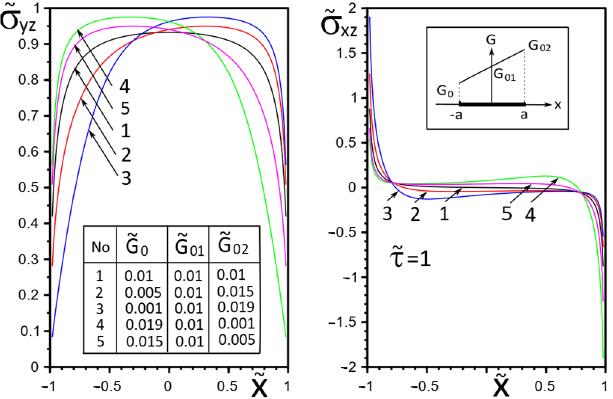
Figure 5. Stress distribution along with the upper interface (inclusion–matrix half-space S 2 ) with a linear distribution of material stiffness.